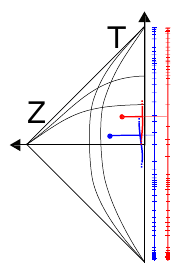
Figure 12 . Set-up of bulk frame using proper time t and the geodesic length L . Both points are the “the same point”, constructed with the same values of t and L , but using a different (off-shell) reparametrization map f